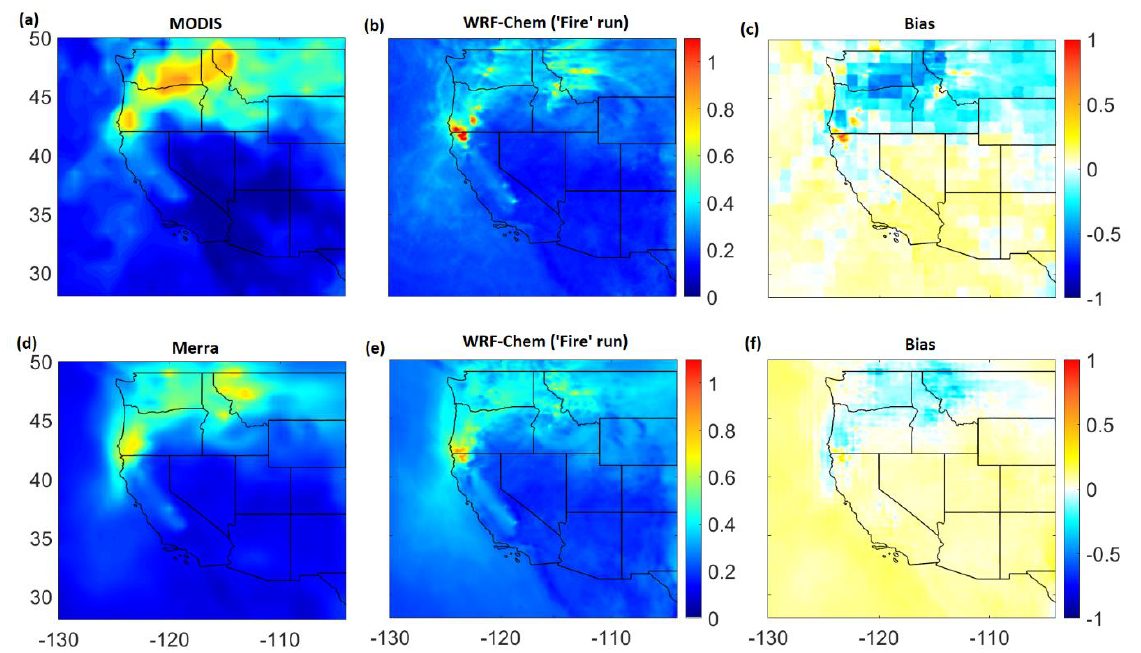
Figure 6. Aerosol optical depth (AOD) ( a ) for MODIS Terra local overpass time, ( b ) for WRF-Chem model (‘Fire’ run) and ( c ) Bias between model and MODIS. Additionally shown is diurnal average aerosol optical depth (AOD) ( d ) for MERRA-2 model, ( e ) for WRF-Chem model (‘Fire’ run), and ( f ) Bias between model and MERRA-2 model.